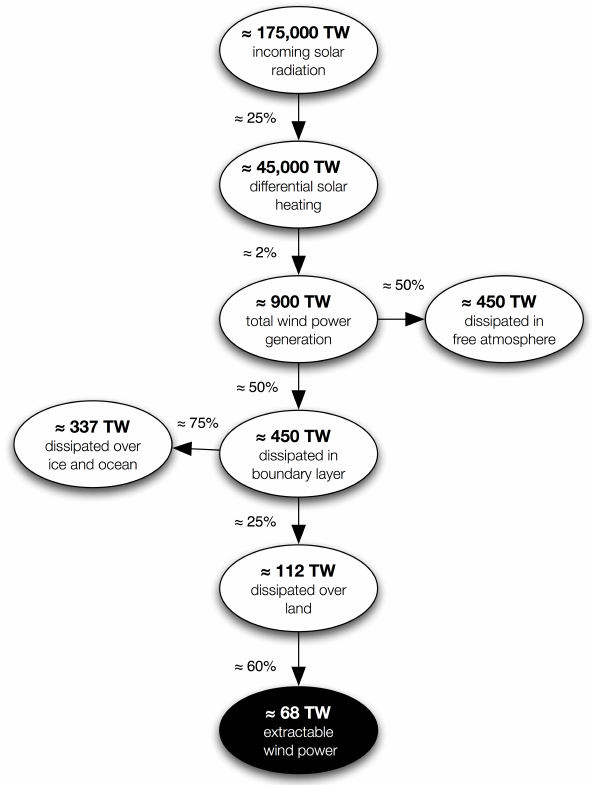
Fig. 1. The conversion processes between incoming solar radiation and extractable wind power over the land in the Earth system is shown. In this simplified framework, assuming a 100% conversion efficiency from mechanical power to electrical power, a maximum of 68TW of electricity can be produced from wind power extraction from the atmospheric boundary layer over all non-glaciated land